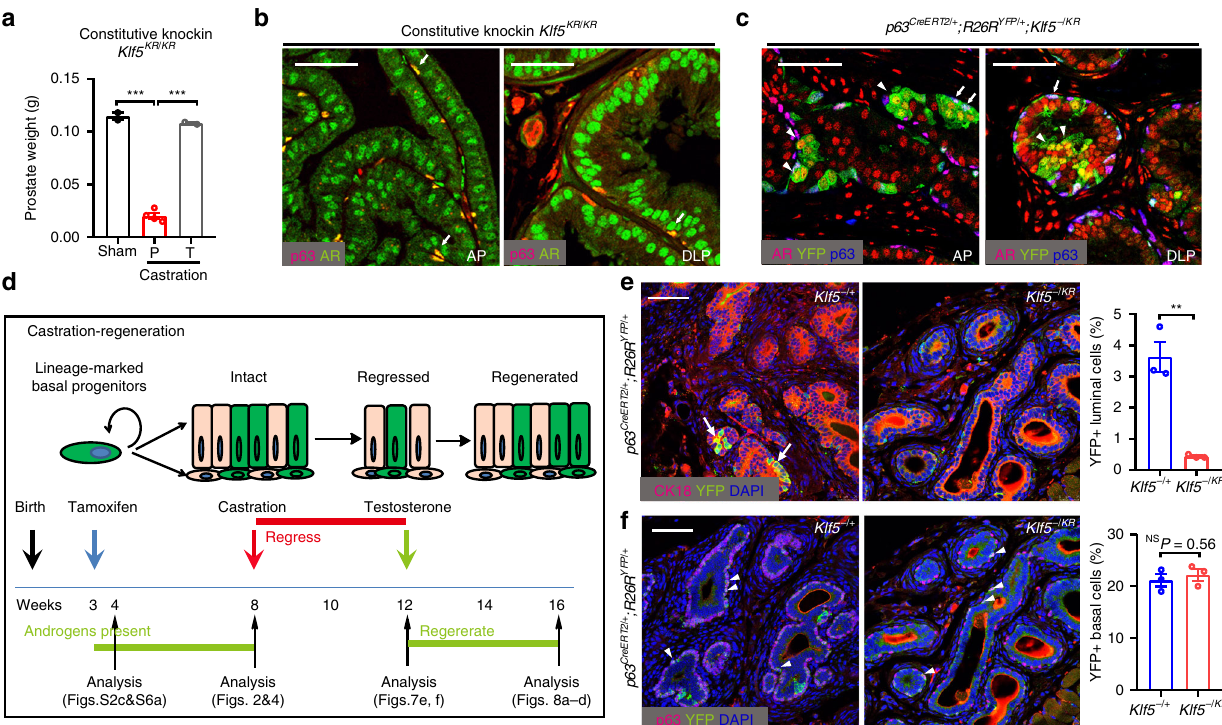
Fig. 7 Deacetylation of Klf5 attenuates the survival of basal progenitor-derived luminal cells following castration. a Prostates with constitutive Klf5 KR knockin still responded to androgen deprivation and restoration, as indicated by prostate weights after castration and androgen restoration. P, placebo; T, testosterone. The numbers ( n ) of prostates: n = 2 for sham; n = 4 for castration + P; n = 2 for castration + T. b , c Expression of androgen receptor (Ar) was maintained in both luminal (indicated by arrowheads) and basal cells (indicated by arrows) in anterior prostates (AP) and dorsal lateral prostates (DLP) with both constitutive ( b ) and induced ( c ) knockins of Klf5 KR (YFP + ), as detected by IF staining. d Schedule schematic for knockin induction by tamoxifen at postnatal day 18, castration at postnatal week (PW) 8, administration of testosterone at PW 12, and regeneration at PW 16. e Castration depleted luminal cells with the Klf5 KR knockin (YFP + ), as revealed by IF staining of the CK18 luminal cell marker and YFP. f Castration did not change the percentage of basal cells with Klf5 KR knockin (YFP + ), as detected by IF staining of YFP and p63. Representative images are selected based on the statistical analysis. Scale bar, 50 μ m. Three mice for each genotype in e and f . Data are shown in mean ± S.E.M. NS not signi fi cant; ** P < 0.01 (two-tailed Student ’ s t -test). Source data are provided as a Source Data fi